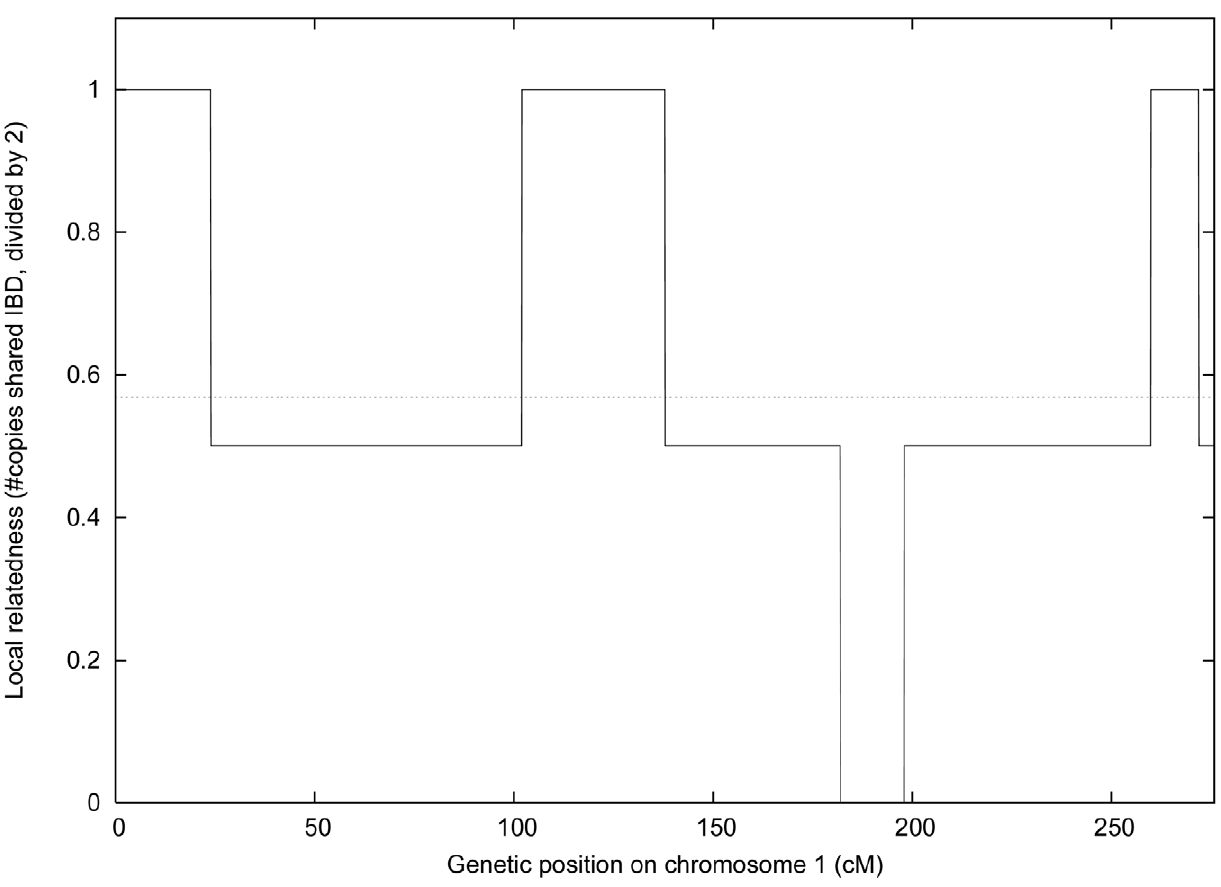
Figure 1. Local and genome-wide IBD. We plot the local relatedness (0, 1 or 2 copies IBD) between two siblings from the IFB cohort at each 2cM block on chromosome 1. The dotted line represents their genome-wide relatedness of 0.568, which is within the expected range for siblings [46].